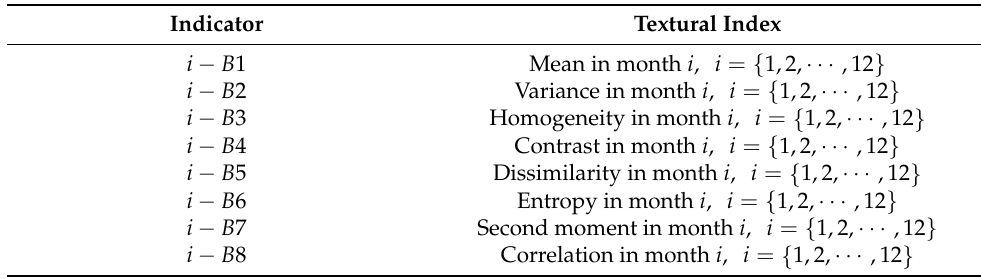
Table 2. Textural indexes and